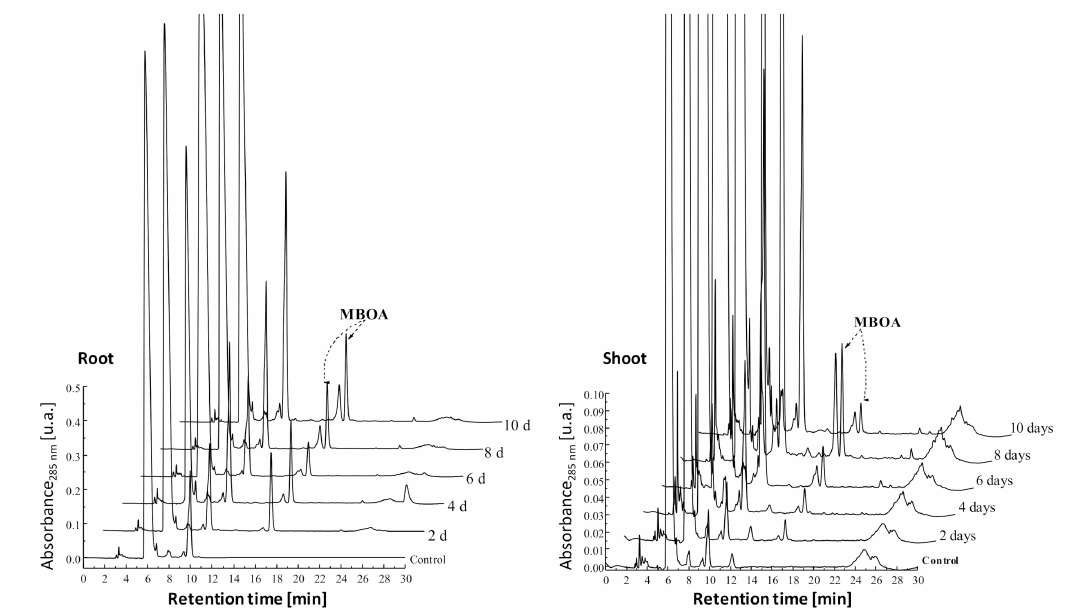
Figure 1. Chromatographic analysis of root and shoot in Lolium rigidum L. seedlings at different incubation times with 3 mM 6-Methoxy-2-benzoxazolinone (MBOA).